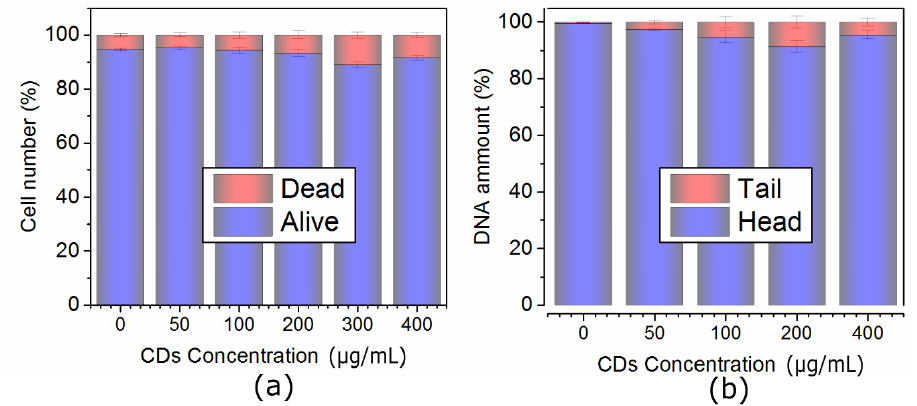
Figure 2. ( a ) Viability and ( b ) genotoxicity of NIH/3T3 cells exposed to the concentration line of QCDs and incubated for 24 h. Please note the following genotoxicity terms: “head” is intact DNA in nucleus, “tail” is damaged DNA migrated away from the nucleus; when the tail value is more than 10%, the dose is